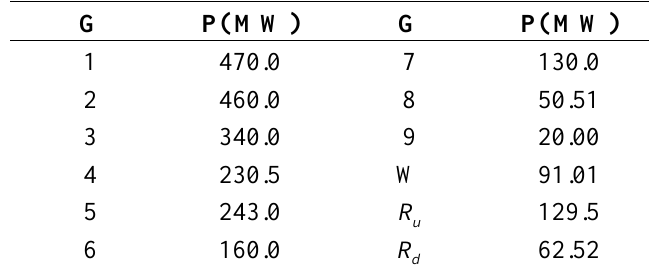
Table 2. Optimal solution using predictor-corrector IP method.